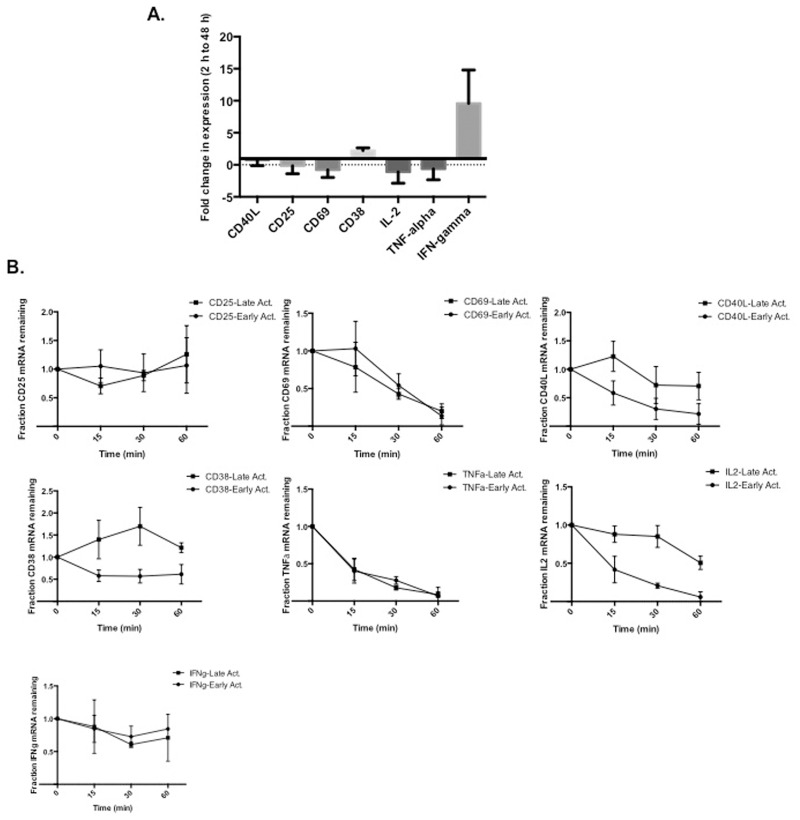
Steady-state RNA expression of different marker genes varies between early and late times of activation.(A) 5 X 106 CD4 T cells were purified from total blood and cultured for 2 h or 48 h with anti-CD3 + anti-CD28 antibodies. Total RNA was reverse transcribed with random primers and analyzed using real time quantitative RT-qPCR. Shown is the fold change in expression between 2 h and 48 h of activation. (B) 2 h and 48 h stimulated CD4 T cells were incubated with DRB (50 μg/ml) for 15, 30, and 60 min. Analysis of RNA levels of the indicated targets was carried out following reverse transcription with poly(A) and RT-qPCR normalized to 18S RNA in each sample. Results represent the average and the SEM of three independent experiments.